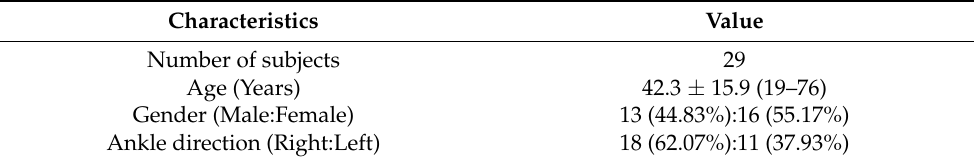
Table 1. Subjects’ characteristics. Characteristics Value Number of subjects 29 Age (Years) Gender (Male:Female) Ankle direction